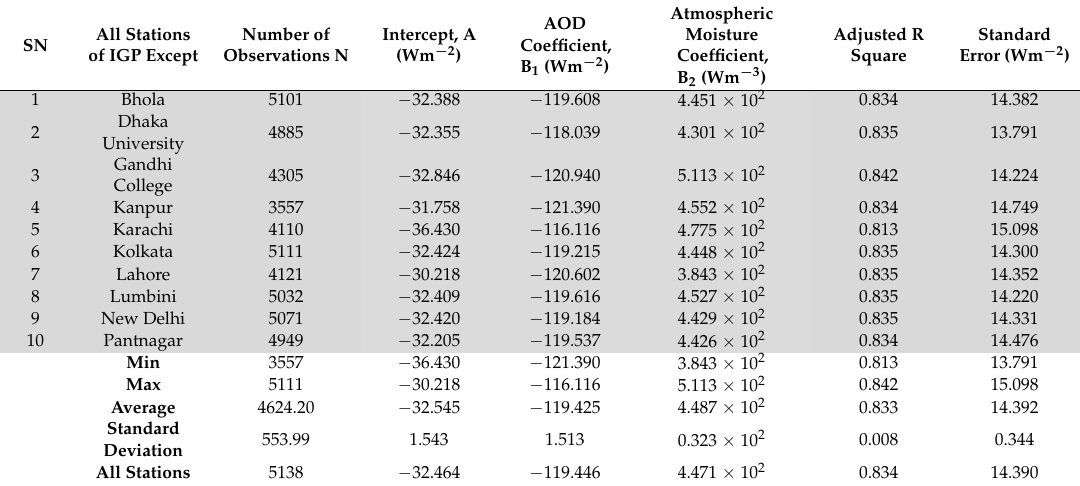
Table 4. Results of multiple regression of ADRF using AERONET AOD and atmospheric water vapour in the IGP by adopting a delete one group (station data) Jackknife